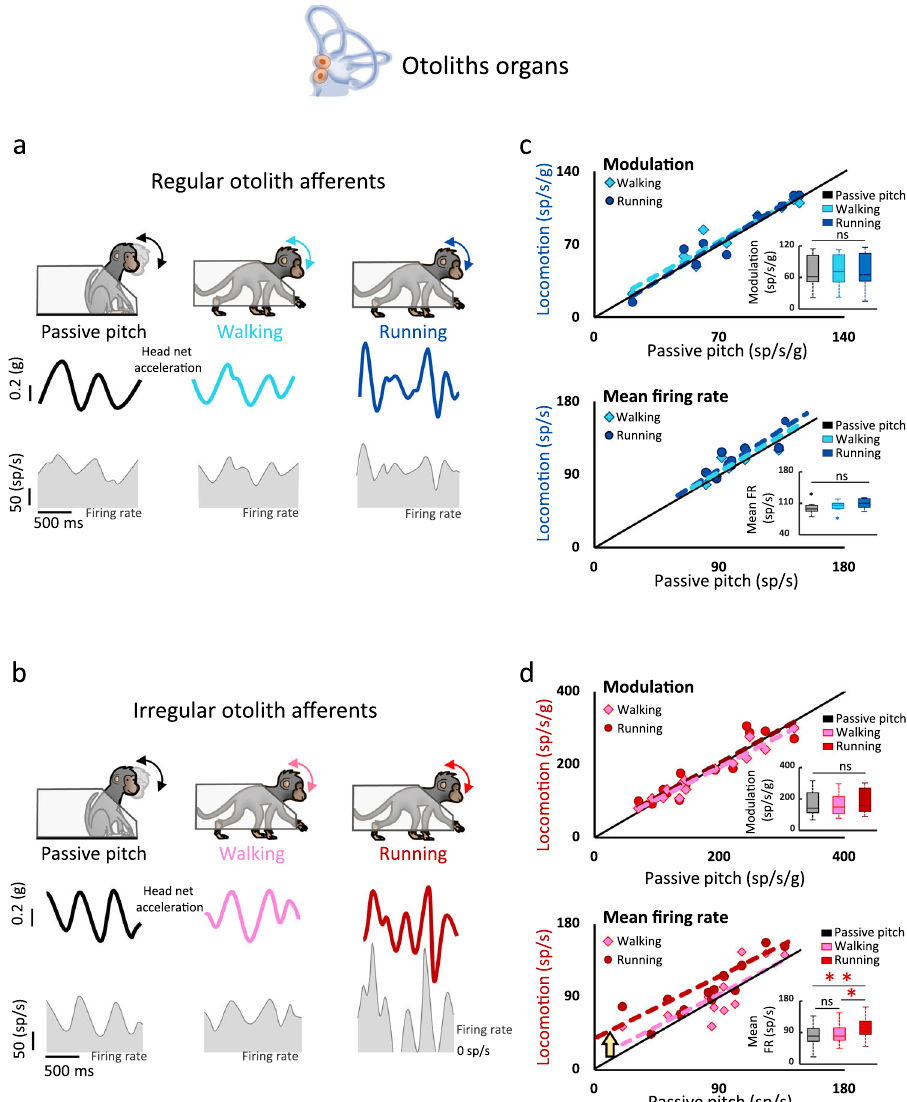
Fig. 3 Irregular otolith afferents demonstrate an increase in mean fi ring rate during running versus walking/passive conditions. a, b Regular and irregular otolith afferents robustly respond in the passive, walking and running conditions. Bottom panels show the fi ring modulation (shaded area) of an example regular afferent ( a ) and an example irregular afferent ( b ) in each condition. c Population comparison of regular otolith canal afferent responses ( n = 9). Neuronal modulations (top panel) and mean fi ring rates (bottom panel) were comparable across all conditions as shown by the slopes of the regressions (top panel ; walking: p = 0.001, slope = 0.95, CI = ±0.27 and running: p = 2.6 × 10 − 4 , slope = 0.93, CI = ±0.35; bottom panel; walking: p = 0.03, slope = 1.01, CI = ±0.37; running: p = 0.05, slope = 1.07, CI = ±0.28; inset: ANOVA, F (2,16) = 0.45, p = 0.65 and F (2,16) = 2.7, p = 0.09 for the modulation and mean fi ring rate, respectively). d Population comparison of irregular otolith afferent responses ( n = 14). Neuronal modulation was comparable during locomotion and passive stimulation (walking: p = 1.3 × 10 − 8 , slope = 0.97, CI = ±0.13 and running: p = 4.0 × 10 − 6 , slope = 0.92, CI = ±0.26, respectively; inset: ANOVA, F (2,26) = 1.03, p = 0.37). In contrast, mean fi ring rate was higher (gold arrow) during running compared to passive pitch and walking (walking: slope = 0.84, p = 0.001, CI = ±0.30; intercept = 14.6 sp/s, p = 0.49; running: slope = 0.77, p = 0.001, CI = ±0.30; intercept = 33.7 sp/s, p = 0.007; inset: ANOVA, F = 6.0, p = 0.007). For all boxplots, the central mark indicates the median, the middle box indicates the 25th and (2,26)